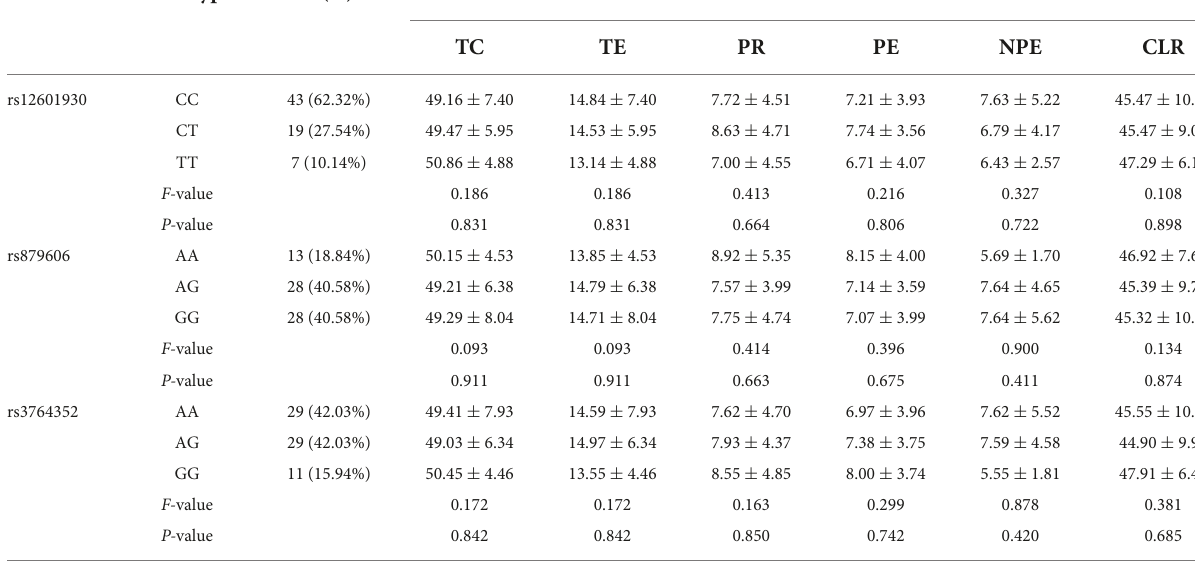
TABLE 3 Effects of PPP1R1B polymorphisms on WCST scores in